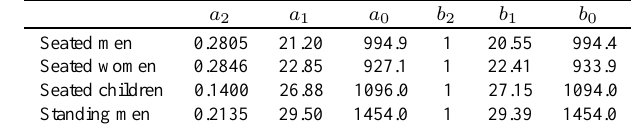
Table 1 Coefficients for transfer functions defining the crowd models for various